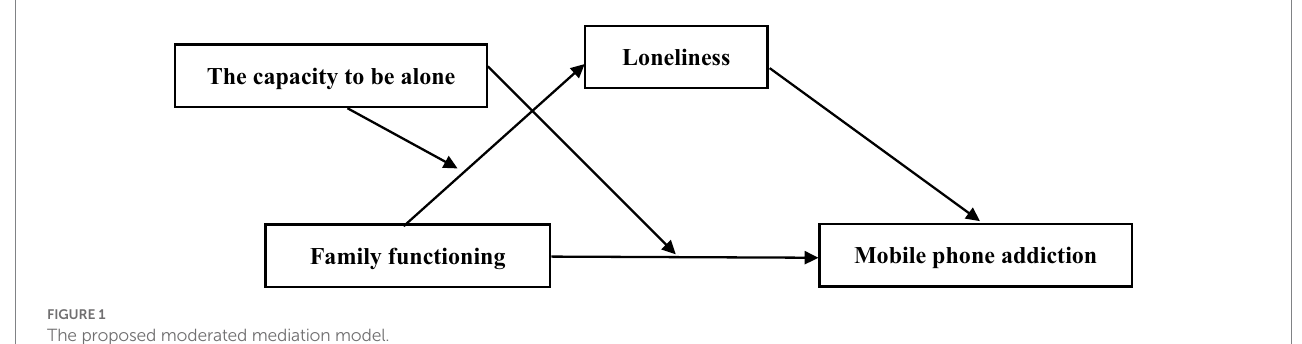
FIGURE 1 The proposed moderated mediation